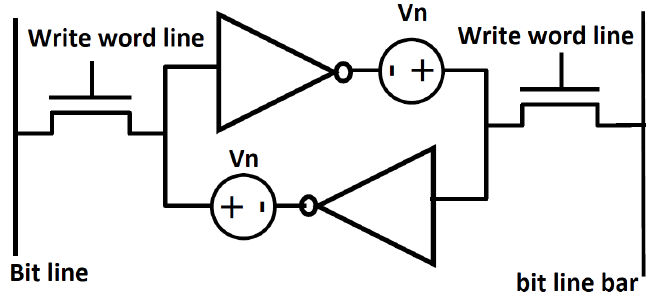
Figure 30. Back-to-back inverter circuit for checking the